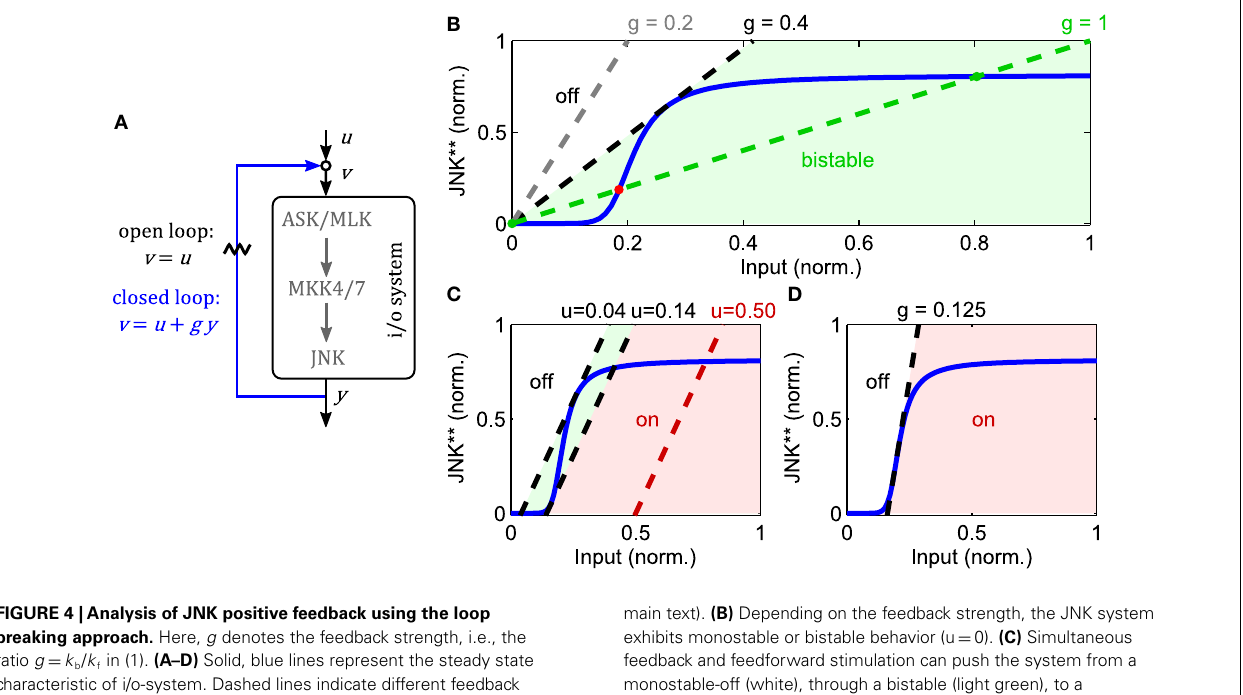
FIGURE 4 |Analysis of JNK positive feedback using the loop breaking approach. Here, g denotes the feedback strength, i.e., the ratio g = k b / k f in (1). (A–D) Solid, blue lines represent the steady state characteristic of i/o-system. Dashed lines indicate different feedback configurations, whereby the slope represents the feedback strength and the rightshift measured from the origin the feedforward stimulus. (A) Illustration of the loop breaking approach (for a detailed explanation see